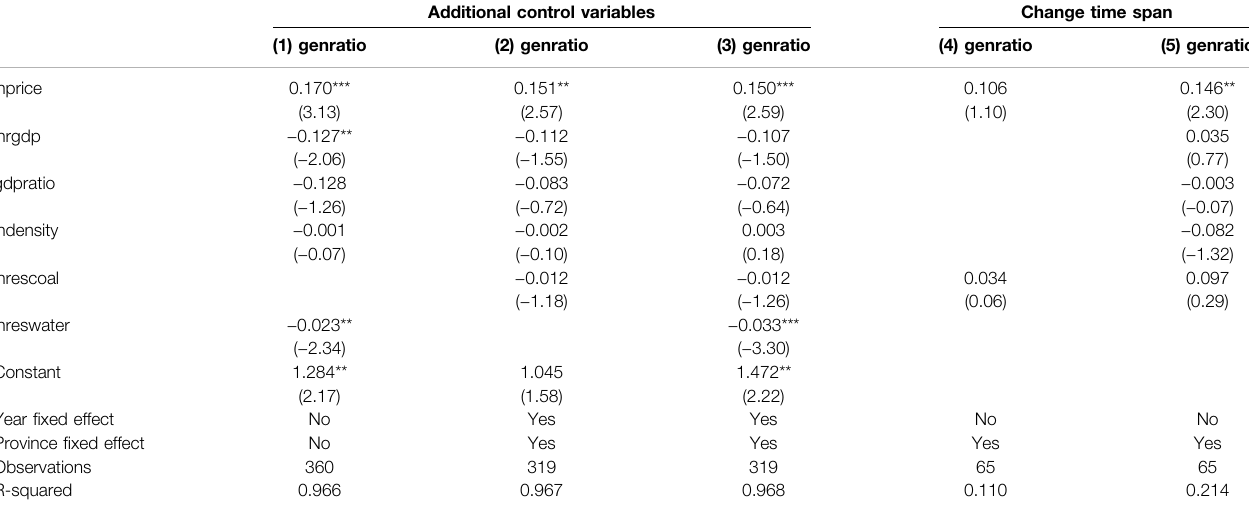
TABLE 3 | Robustness tests.